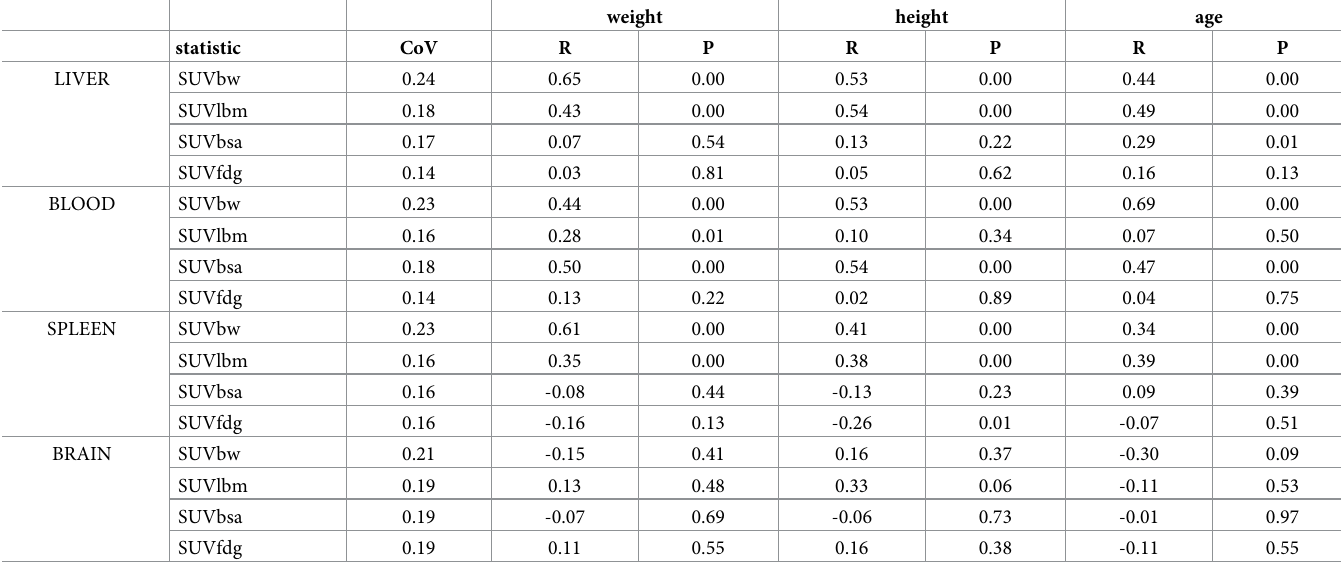
Table 3. Independent test cohort results.